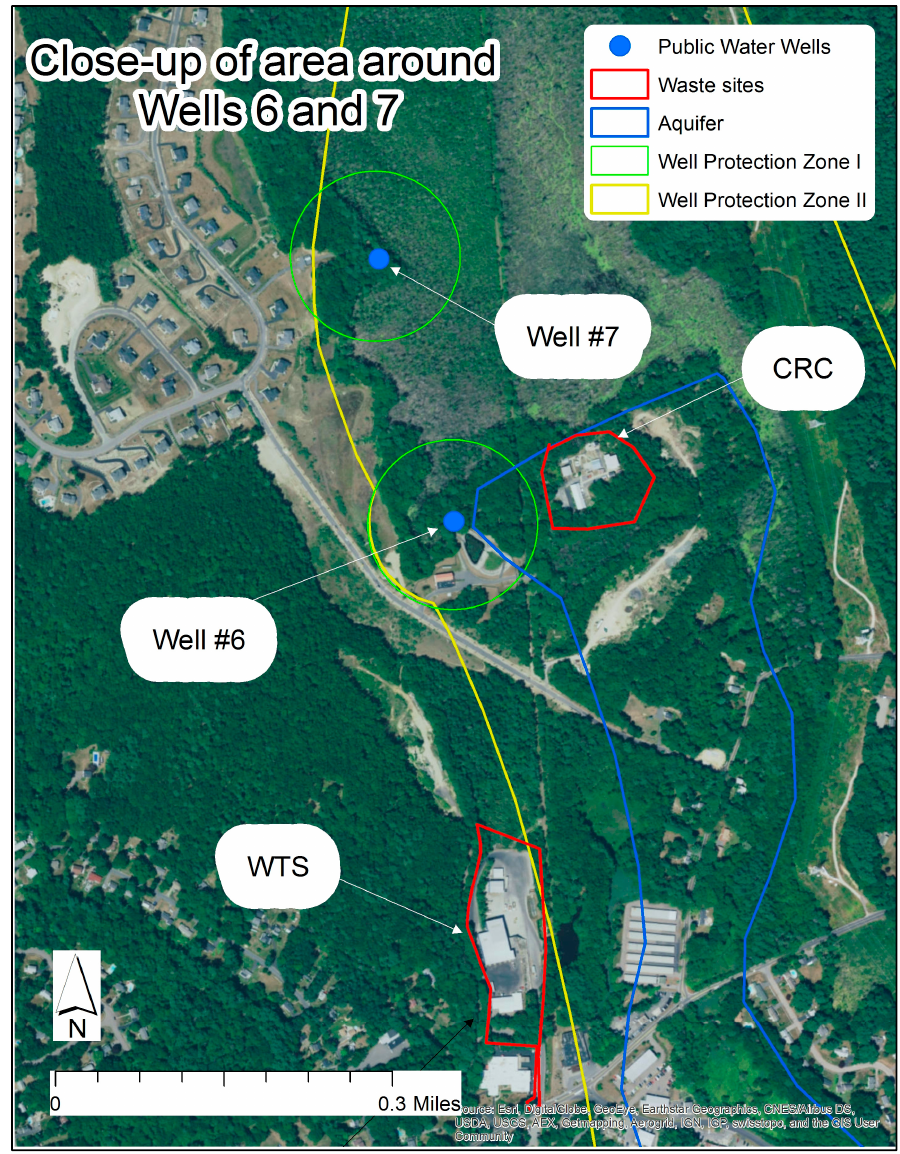
Figure 3. Close-up of area around Wells #6 and #7. Data sources: Google Earth ® (from